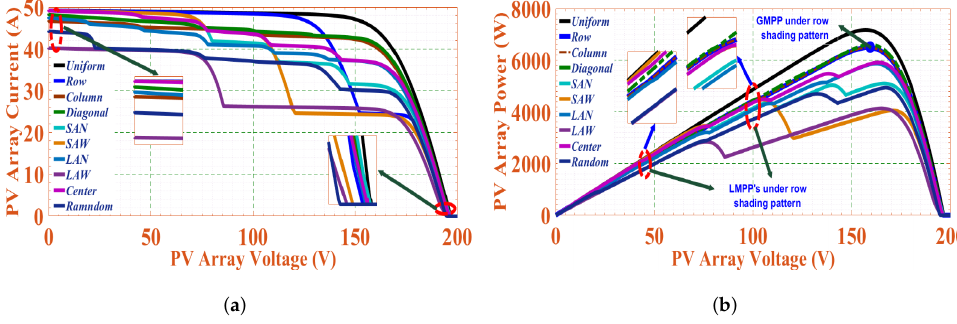
Figure 13. H-C-T-C-T topology results under various PSCs. ( a ) I-V characteristics, ( b ) P-V characteristics.